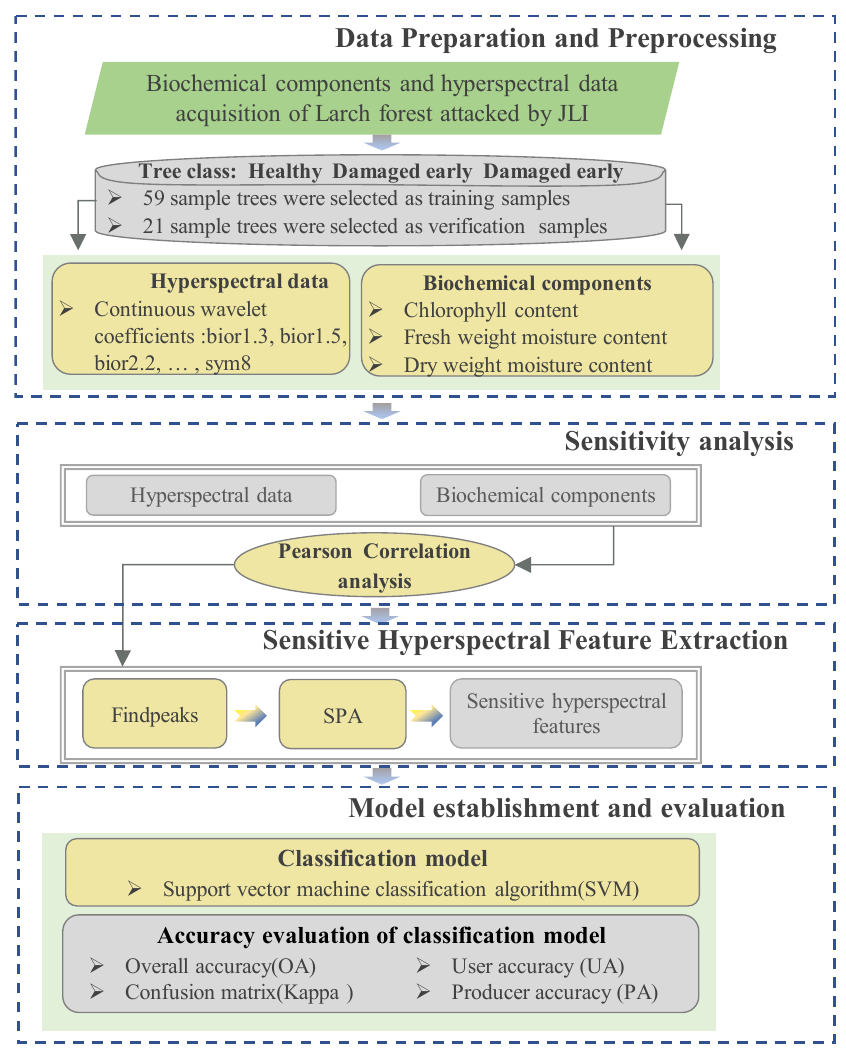
Figure 3. Overall research technical route. Table 2. Descriptive statistics of biochemical components of different types of sample